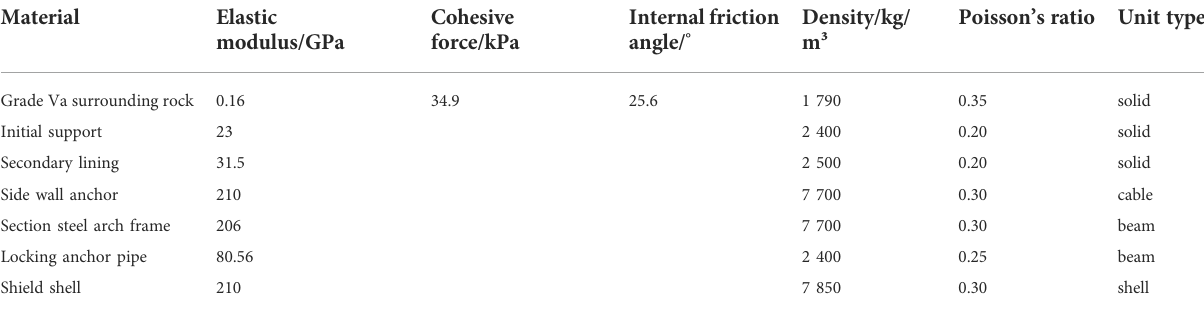
TABLE 2 Model parameters for the grade Va surrounding rock.